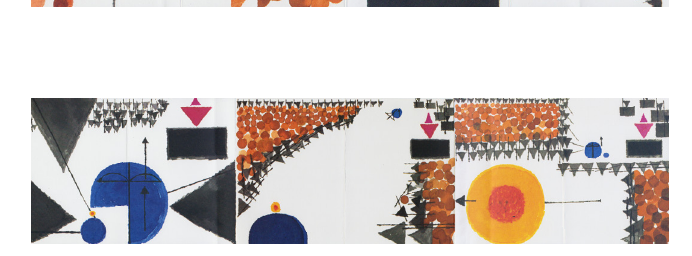
Fig. 11 Warja Lavater, Tell is and taken by boat ; Tell leaps onto the shore and pushes the boat into the waves . Warja Lavater (1962). Wilhelm Tell. Basel: Basilius